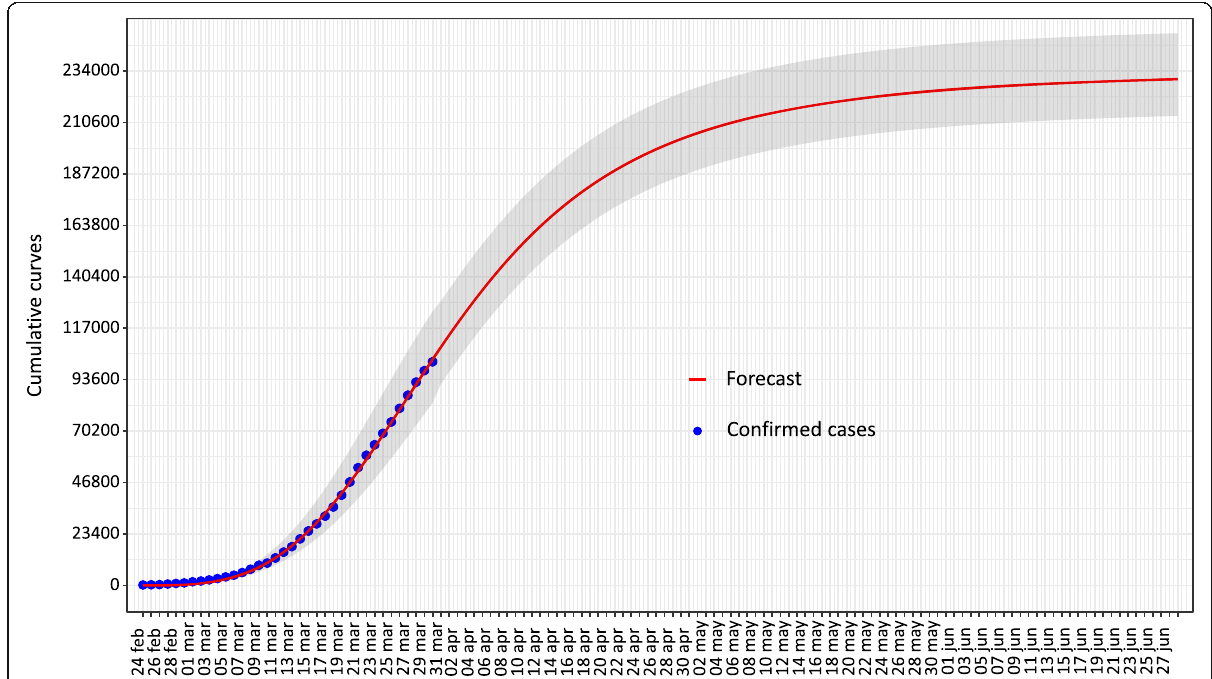
Fig. 3 Cumulative curve obtained by the forecasted model of the epidemic in Italy in real-time. Predictions are represented by the red line, with the gray area to indicate 95% CI. The blue points represent the confirmed